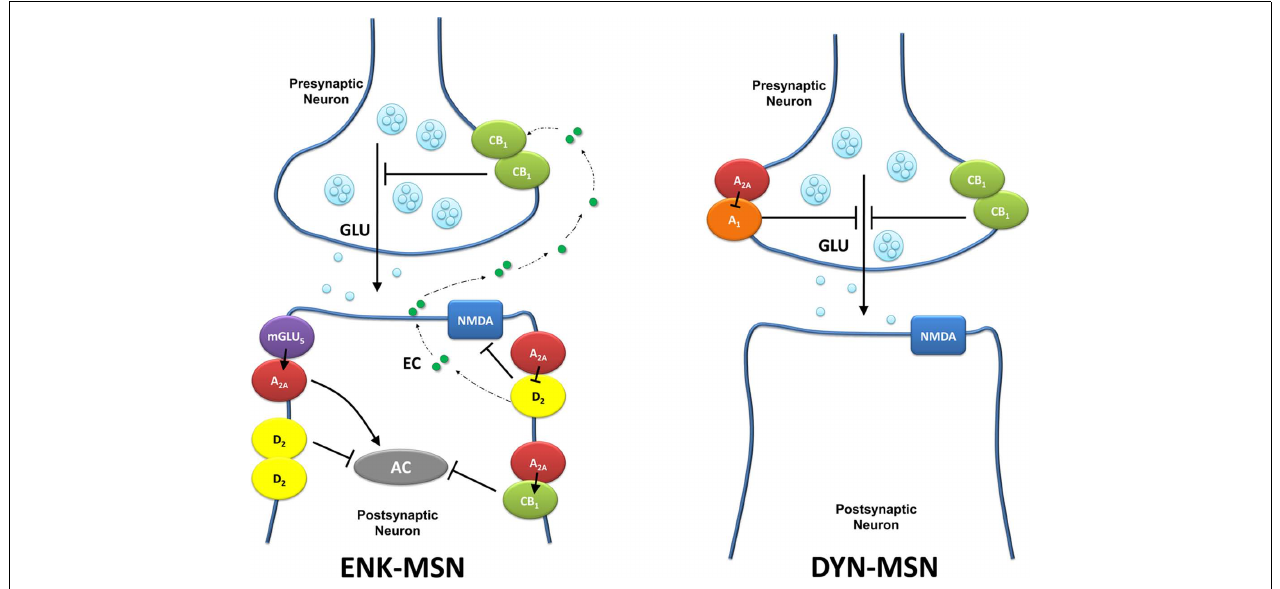
FIGURE 1 | Schematic representation of the different subpopulation of striatalA 2A Rs. Presynaptic A 2A Rs are localized in glutamatergic terminals that contact the dynorphynergic medium spiny neuron (DYN-MSN), where they form heteromers with A 1 Rs. Postsynaptic A 2A Rs are localized in the enkephalinergic medium spiny neuron (ENK-MSN), where they from heteromers with D 2 Rs, CB 1 Rs, and mGlu 5 Rs. AC, adenylyl cyclase; EC, endocannabinoid; GLU,